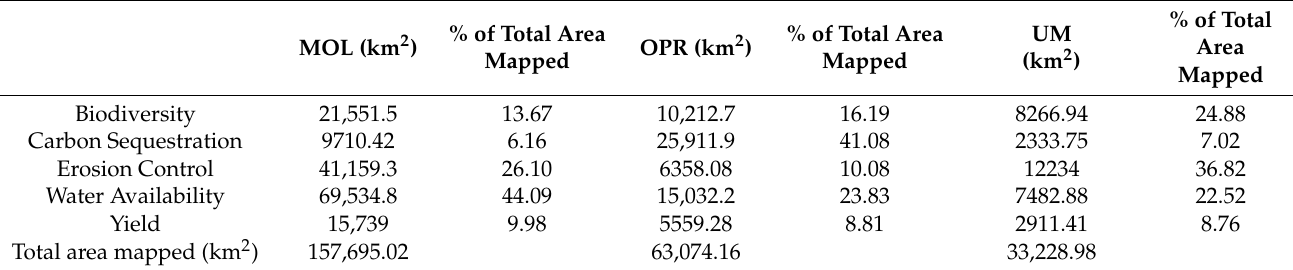
Figure 4. Average supply and demand assessment for ES in all three CSAs. Table 5. Area mapped in km 2